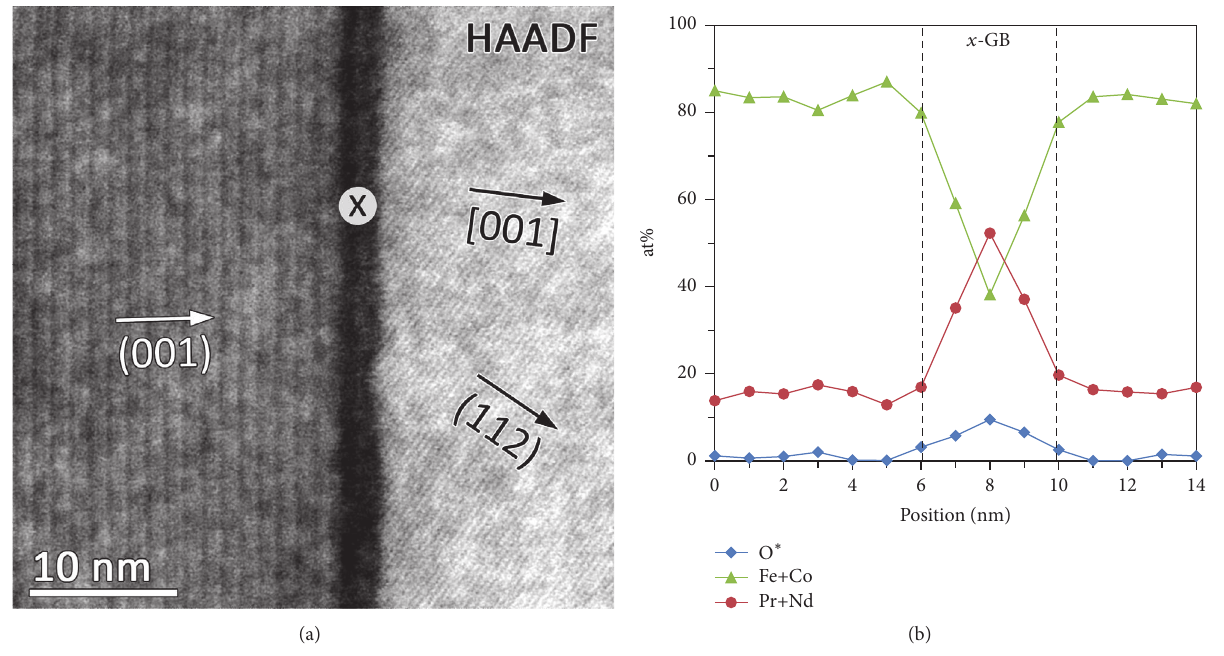
Figure 6: (a) HAADF image of an 𝑥 -GB, (001) lattice fringes of the left grain, and (112) lattice fringes of the right grain are visible; (b) EELS line scan over the GB in (a); significant rise in the RE concentration in the GB.